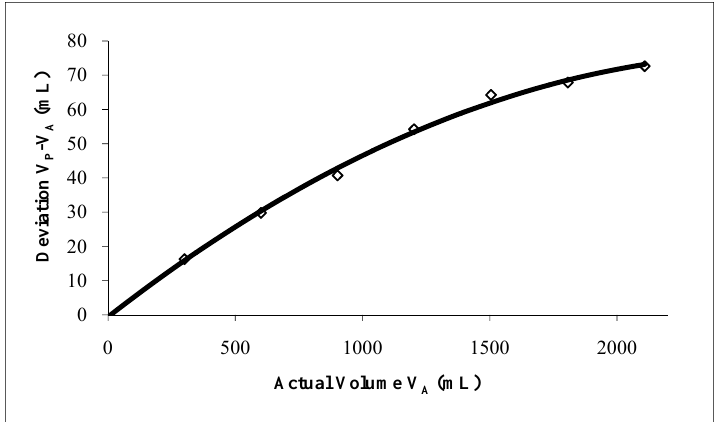
Figure 4. Actual water volume versus deviation volume ( V equation with 3 L chamber, 170 mm long, and 44 mm diameter